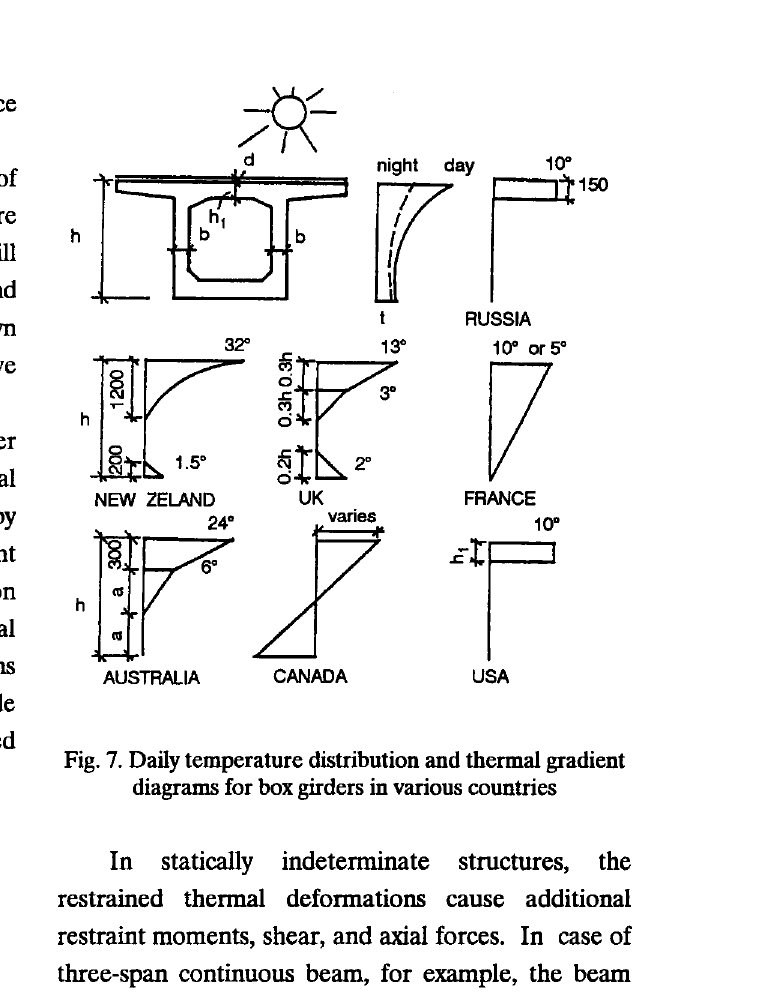
Fig. 7. Daily temperature distribution and thermal gradient diagrams for box girders in various countries In statically indeterminate structures,